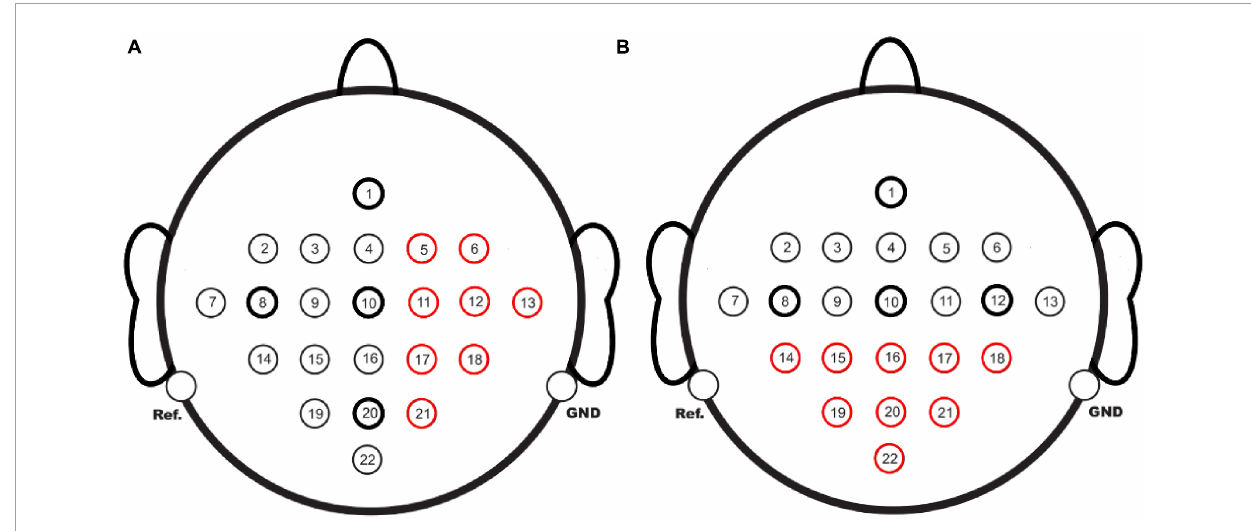
FIGURE11 EEG channels to be completed, (A) using 1st, 8th, 10th, and 20th channels to supplement the 8 red-marked channels. (B) Using 1st, 8th, 10th, and 12th channels to supplement the 9 red-marked